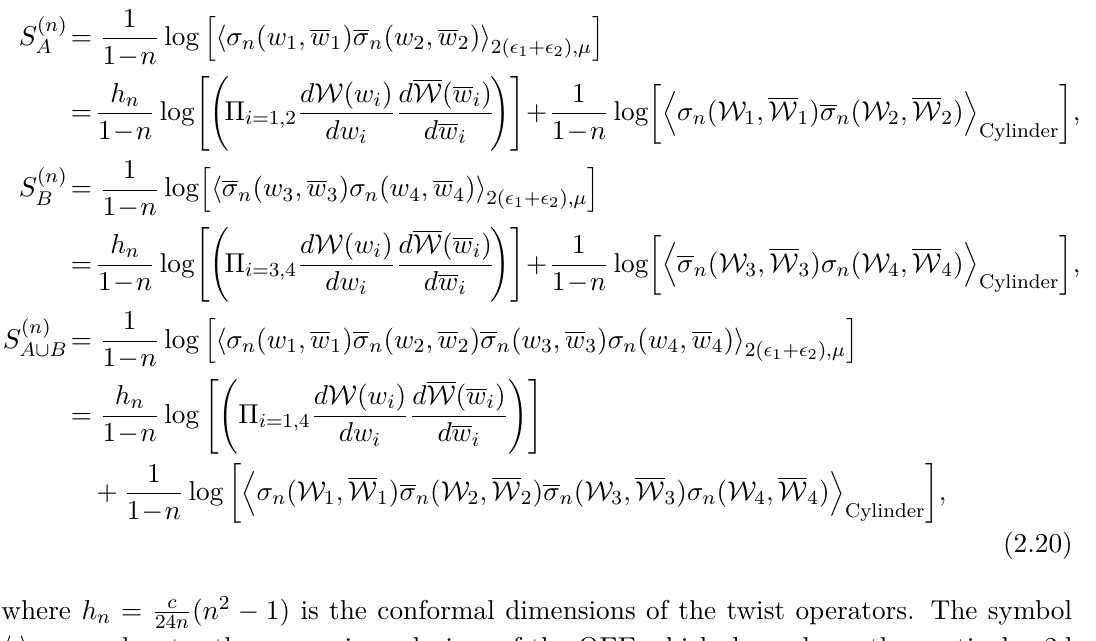
Figure 2 . A cartoon of the cylinder and torus in the W and W coordinate system. In Panel [a], the cylinder in W and W coordinate system is shown. The regions where we perform the measurement is mapped onto the top and bottom of the cylinder which are shown here in orange. Panel [b] shows the real part of the location of the original operator (red point) and its image (blue